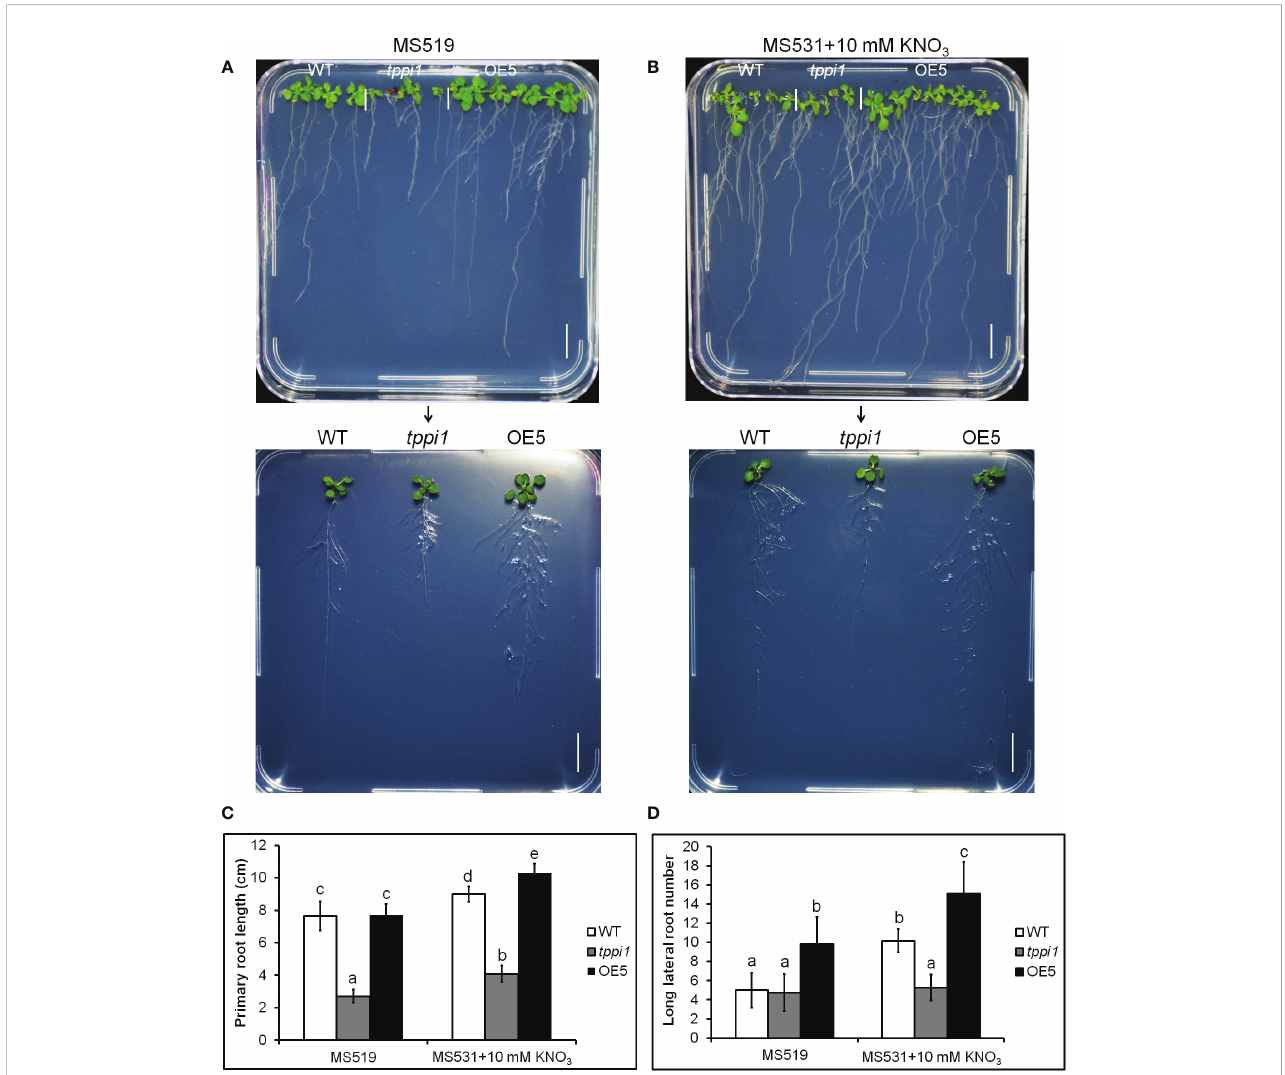
FIGURE 6 AtTPPI increase lateral root number under high nitrate condition. (A, B) The phenotype of WT, tppi1 mutant, OE5 plant on MS vertical medium (MS519, A ) and MS vertical nitrogen-de fi ciency medium (MS531+10 mM KNO 3 , B ) for two-week days, Bar = 1 cm; (C) The primary root length statistical analysis of WT, tppi1 mutant, OE5 plant on MS vertical total nitrogen medium (MS519) and MS vertical nitrogen free medium with 10 mM KNO 3 (MS531+10 mM KNO 3 ) for two-week days. Error bars indicate SEs (n = 3). Different lowercase letters (a – e) indicate signi fi cant differences among lines (Duncan ’ s test; p < 0.05); (D) The lateral root number statistical analysis of WT, tppi1 mutant, OE5 plant on MS vertical total nitrogen medium (MS519) and MS